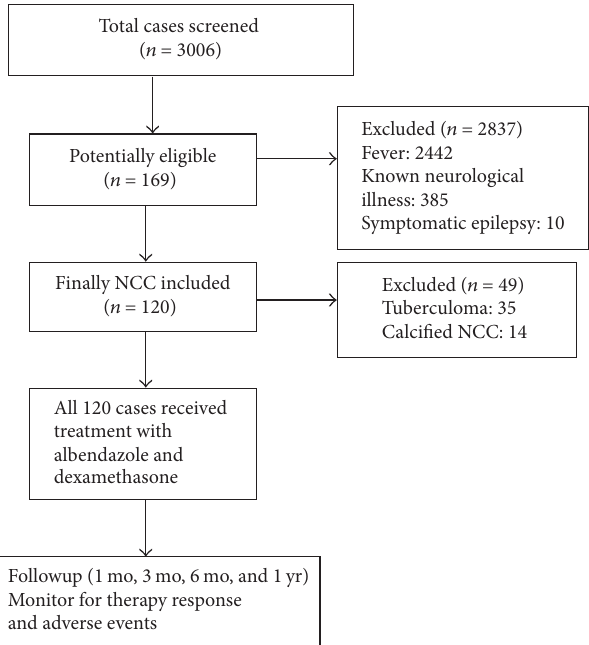
Figure 1: Flow diagram showing recruitment of cases into the